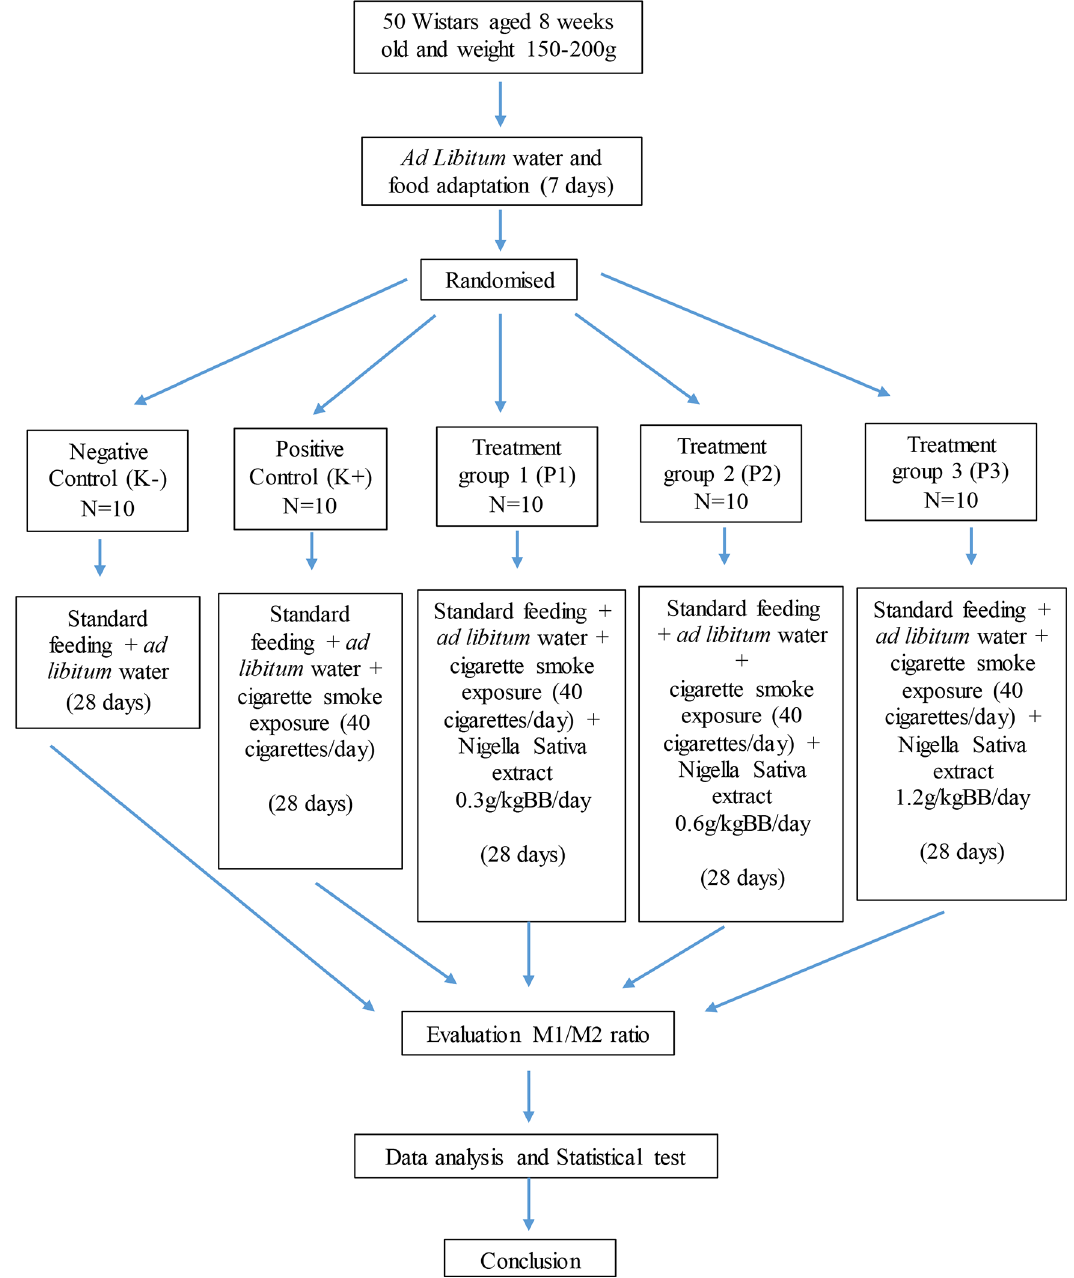
Figure 1. Conceptual framework of study